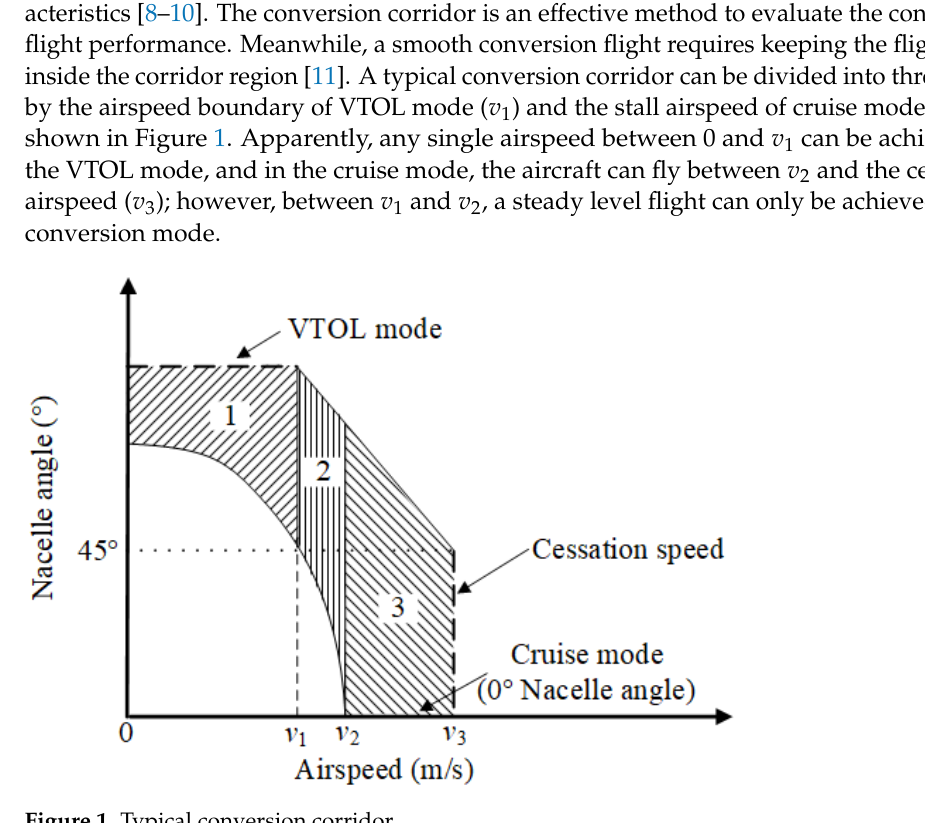
Figure 1. Typical conversion